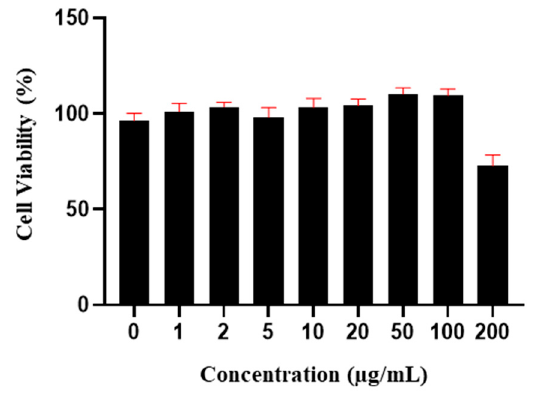
Figure 8. LDH assay cytotoxicity analysis of GQDs-hMSNs up to 200 µg/mL in RAW 264.7 cells.